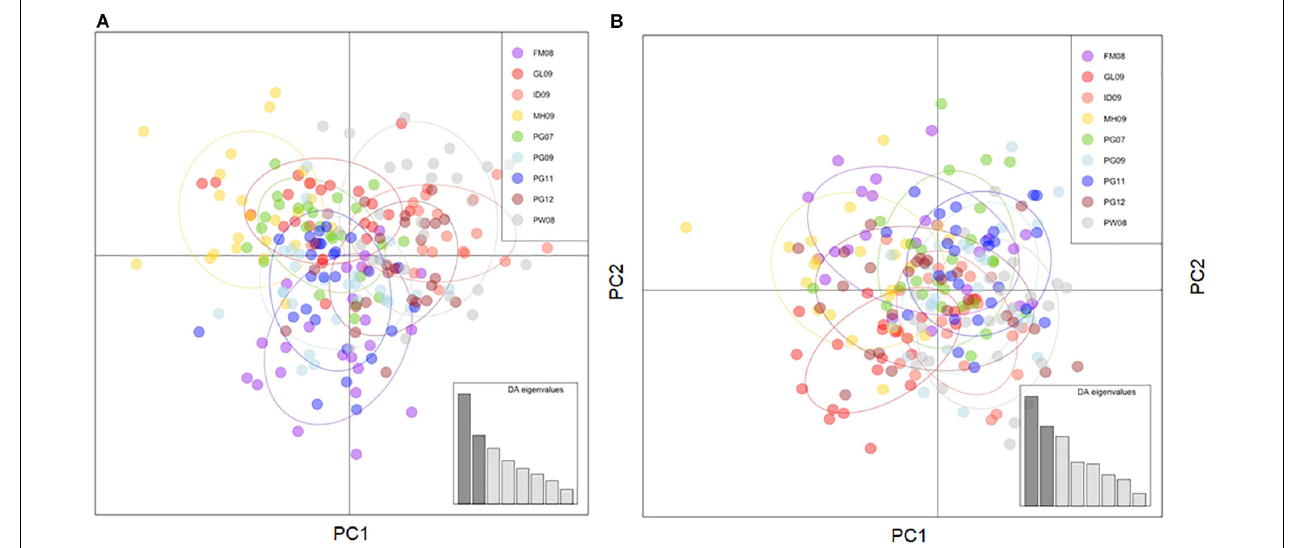
FIGURE 2 | (A) DAPC using neutral loci from the primary dataset, 47 principle components, and 8 degrees of freedom. (B) DAPC using LUPS dataset, 34 principle components, and 8 degrees of freedom. Placement of individuals relative to each other reflects their genetic similarity and extent of genetic admixture irrespective of the purported neutrality of potential